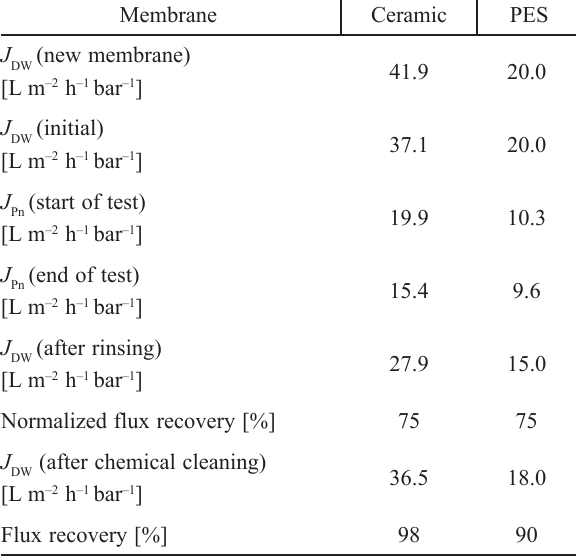
Table 2 – Normalized permeate flux of ceramic and poly­ ethersulfone (PES) membrane after rinsing and chemical clean­ ing for ultrafiltration tests with textile wastewater (T = 20 °C) Membrane Ceramic